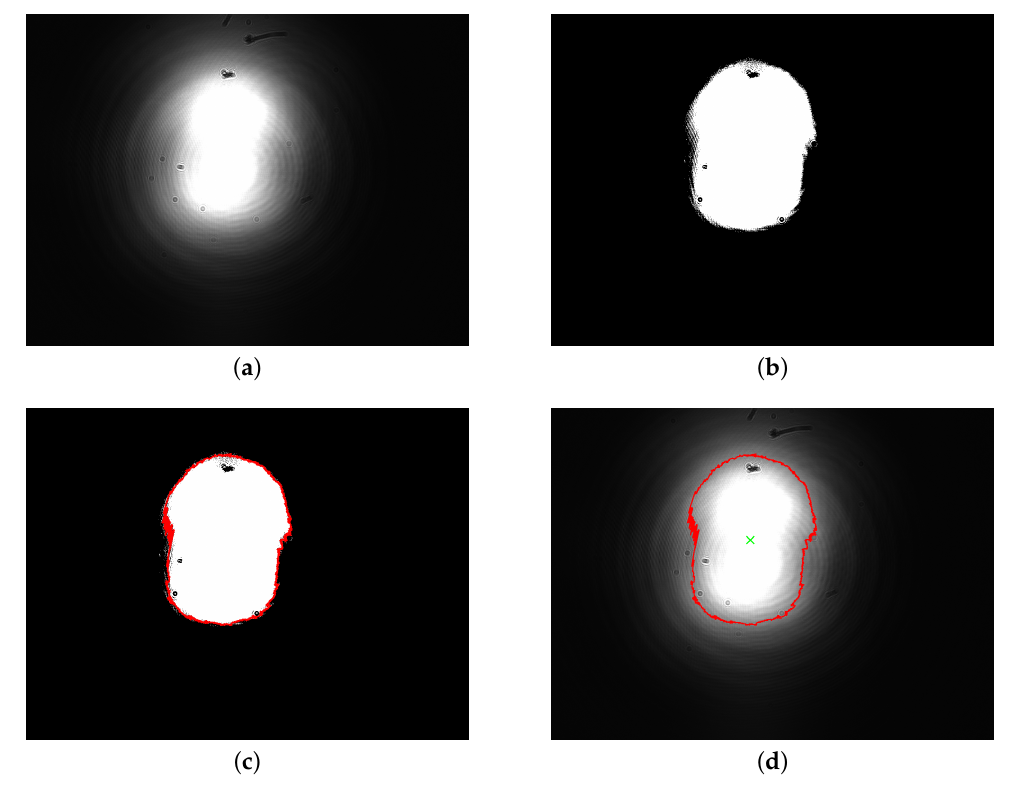
Figure 1. Steps of the image moment method applied to the original image sample19 : ( a ) 8-bit single channel gray scale image; ( b ) binary image, obtained using the threshold value I th = 2 7 ; ( c ) contour detection using the binary data; ( d ) centroid